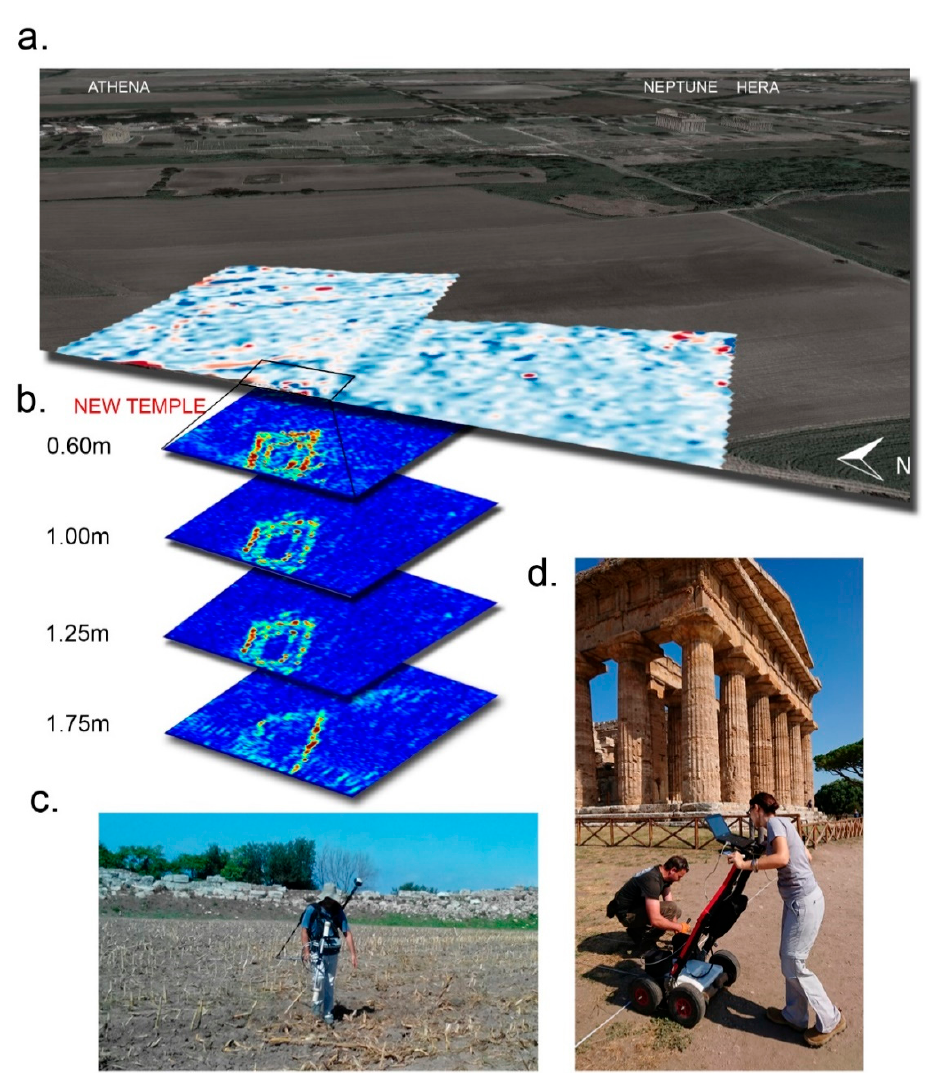
Figure 11. The geomagnetic map ( a ) and the GPR slices ( b ) allowed us to obtain the described results. The complementary work by MAG ( c ) and GPR ( d ) surveys at increasing resolutions was aimed at discovering and reconstructing the archaeological structures potentially buried in the subsoil.